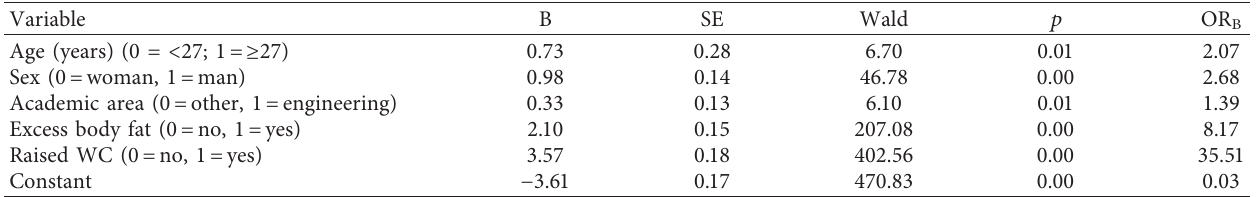
Table 6: Binary logistic regression analysis of factors associated with overweight/obesity in university students.